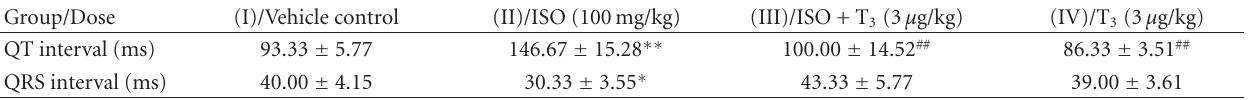
Table 1: E ff ect of T 3 on electrocardiogram parameters in ISO-induced cardiac changes.